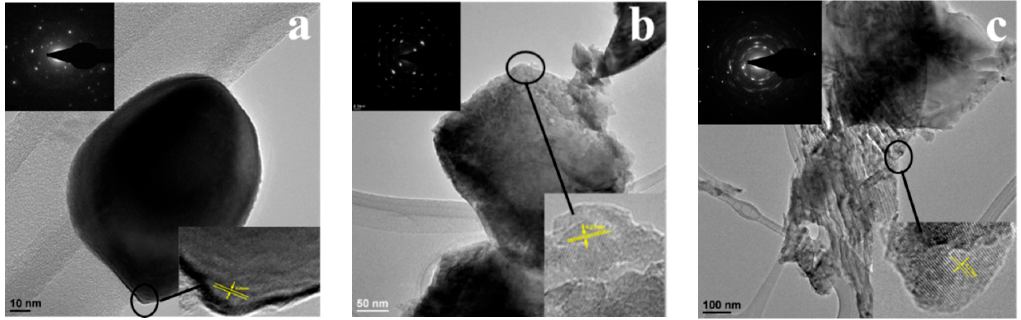
Figure 6. TEM images of Fe 2 O 3 at different calcination temperatures ( a ) 500 °C ( b ) 700 °C ( c ) 900 °C.